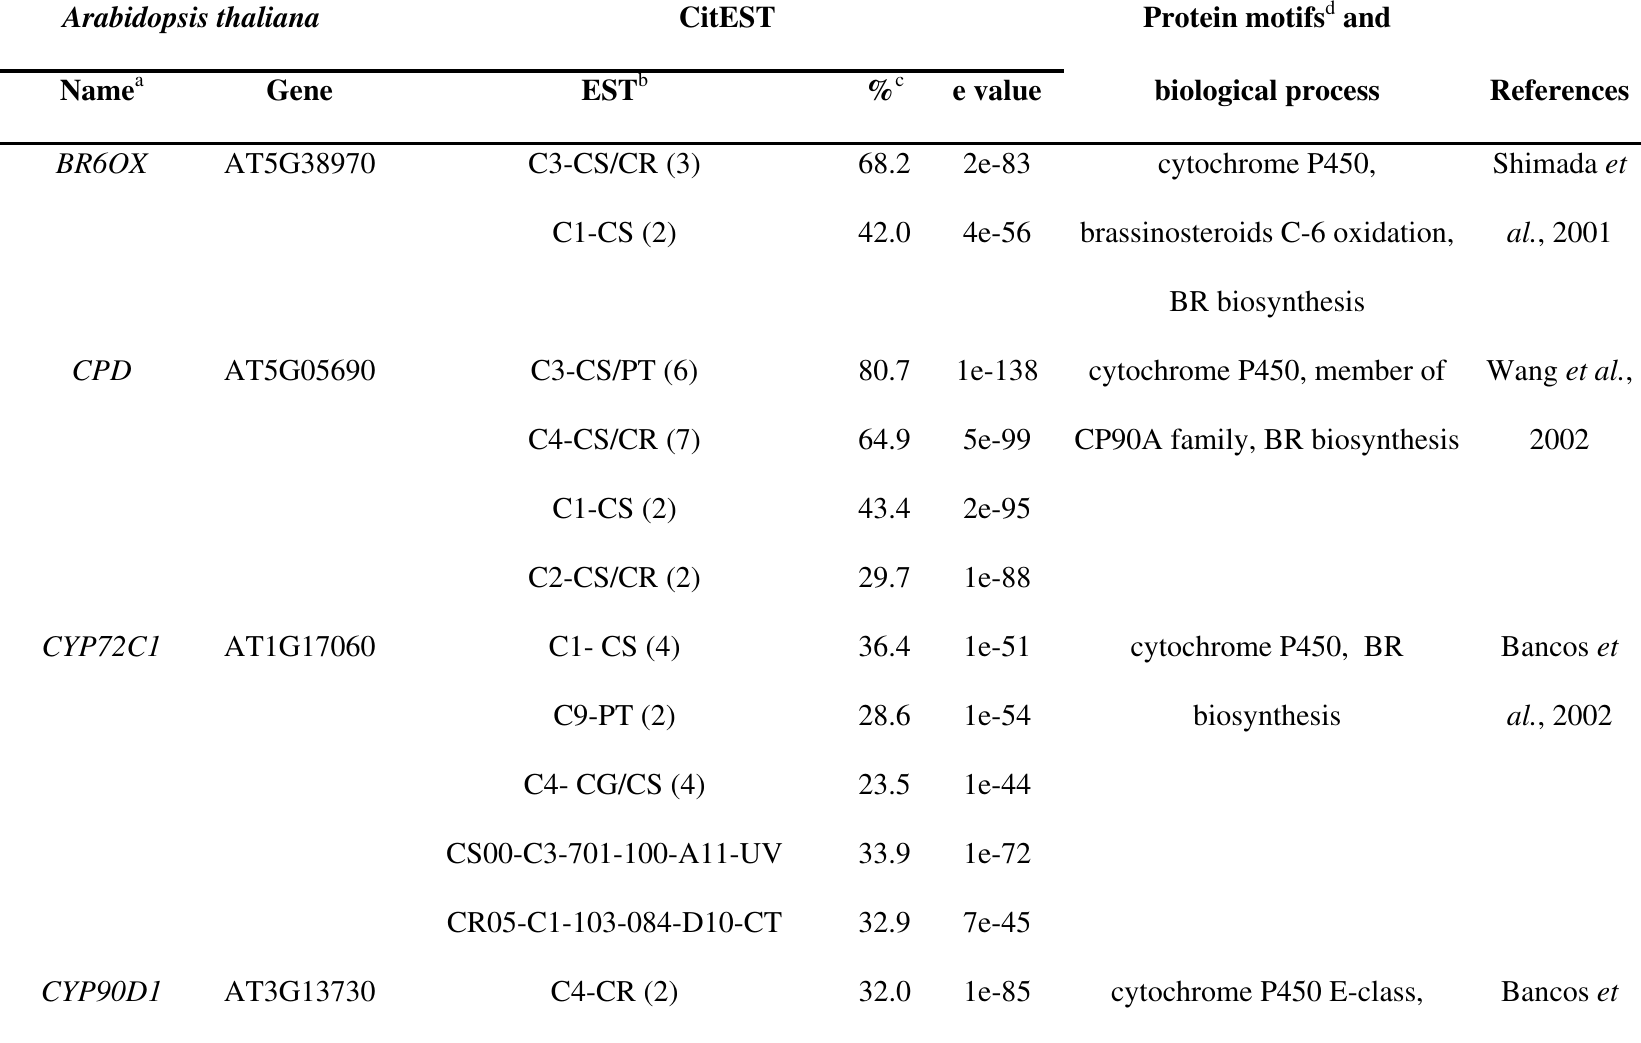
Table S4 – Citrus ESTs with homology to genes involved in brassinosteroid metabolism in Arabidopsis thaliana